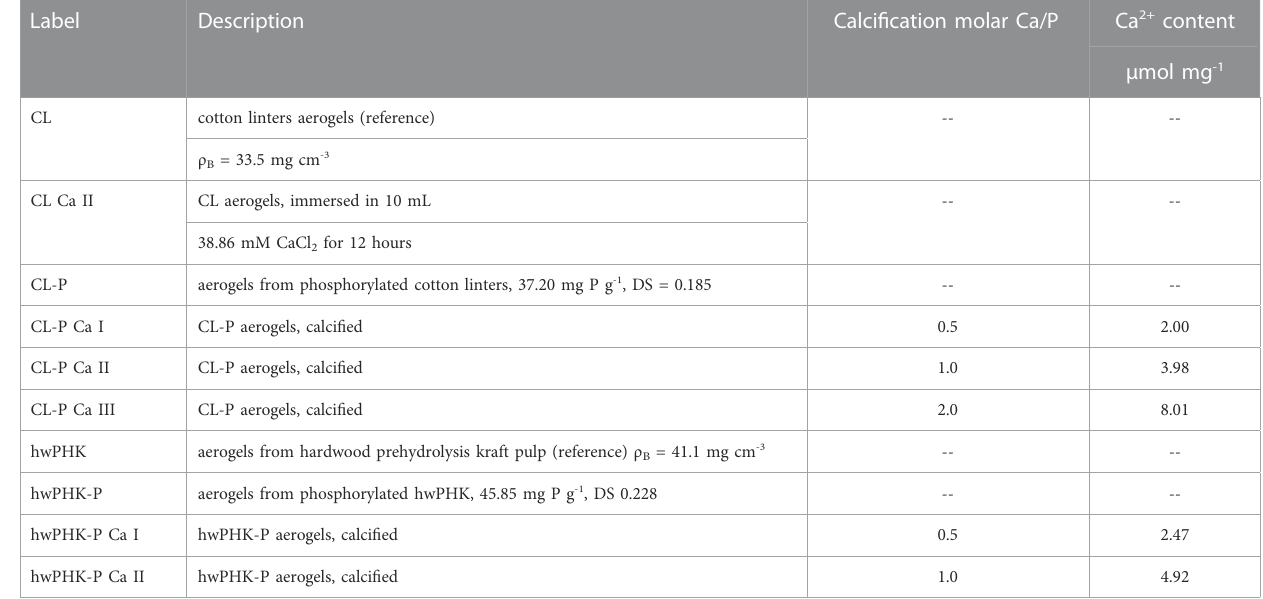
TABLE 1 Samples used in the hemocompatibility assay.